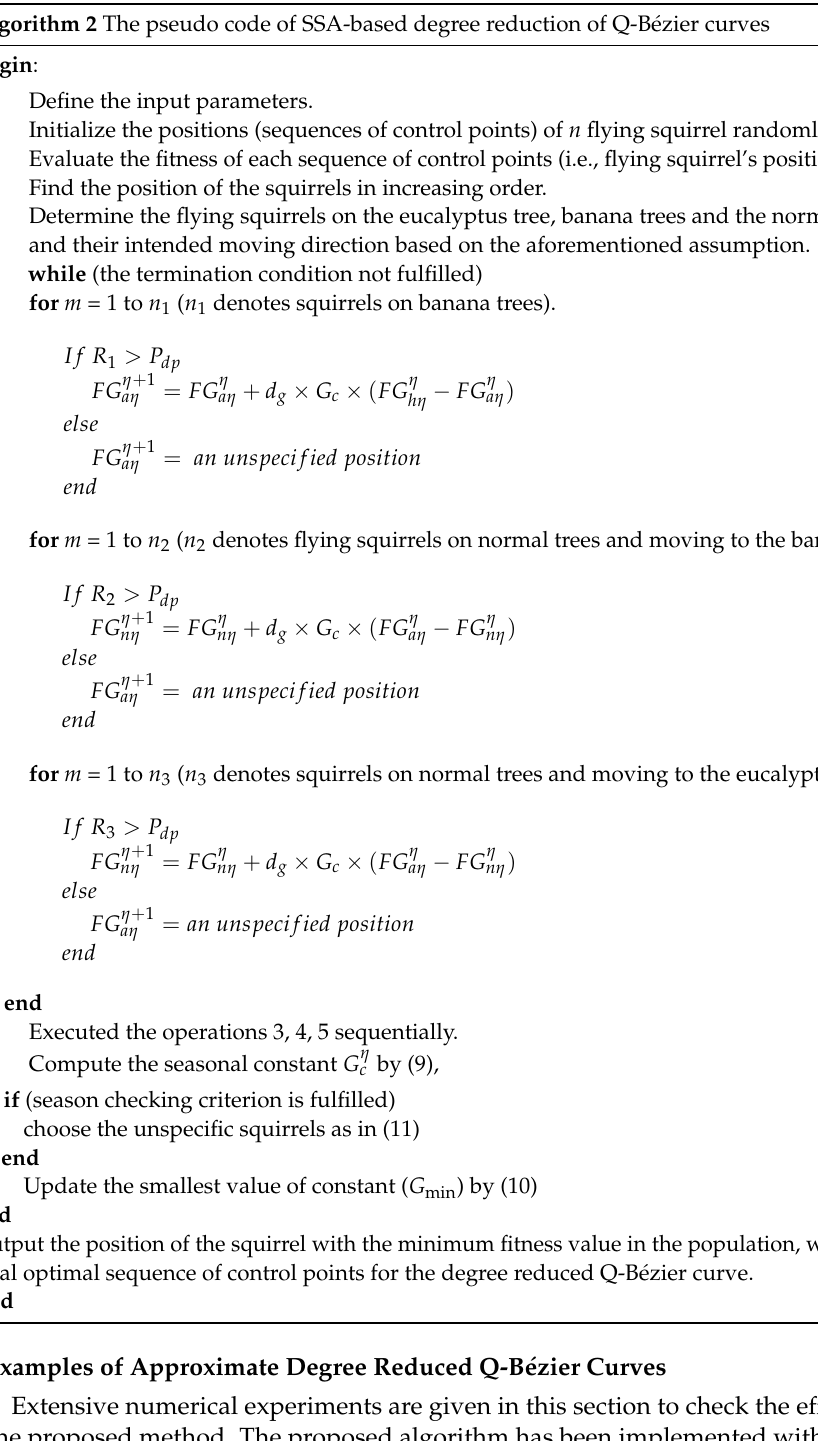
Algorithm 2 The pseudo code of SSA-based degree reduction of Q-B é zier